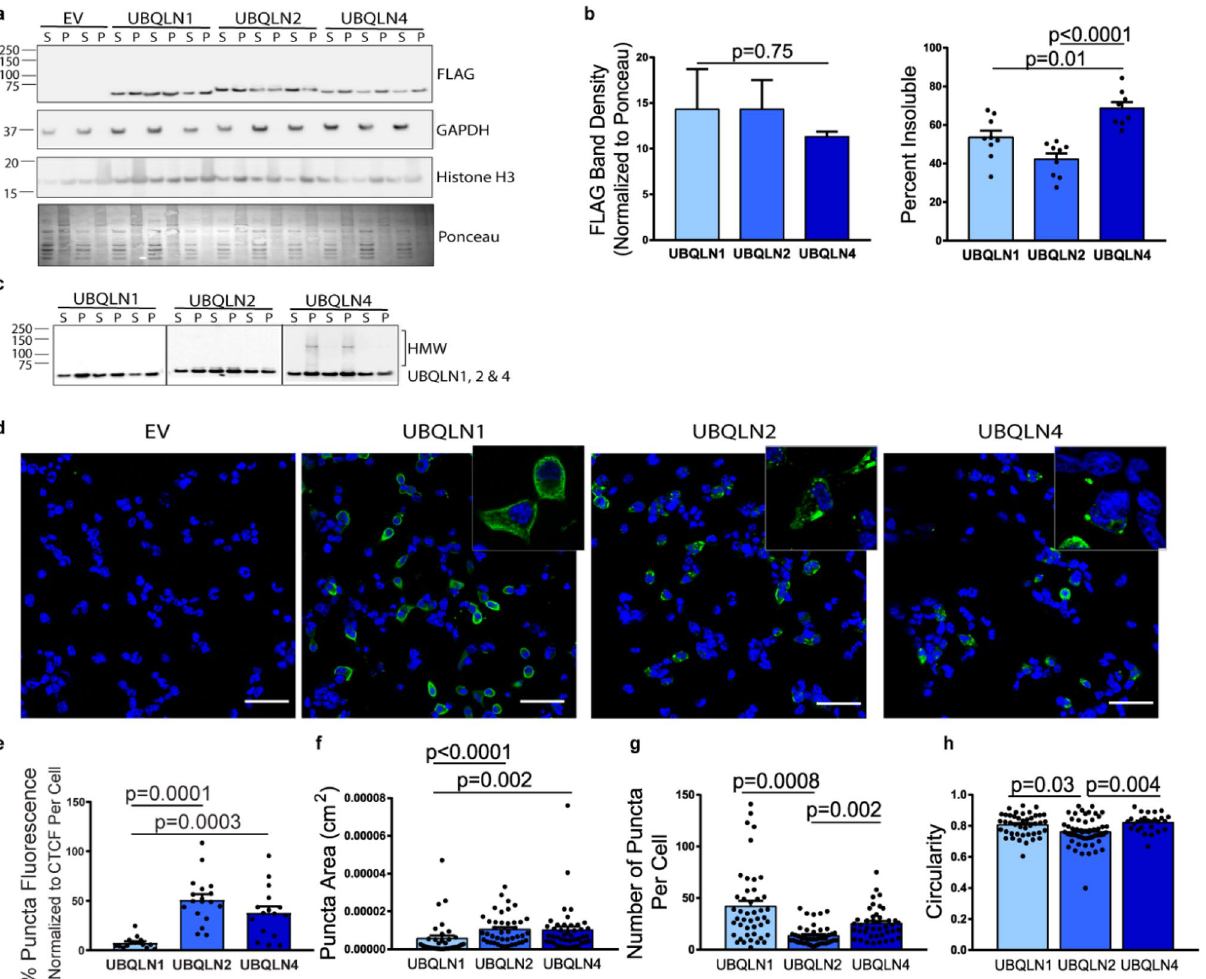
Figure 3. In transfected cells, UBQLN4 and UBQLN2 display enhanced aggregation and puncta formation compared to UBQLN1. ( a ) Of the three tested ubiquilins expressed in HEK-293 cells, FLAG-UBQLN4 is most prone to deposit in the PBS-insoluble (P) fraction versus the PBS-soluble (S) fraction (n = 9). Both cytoplasmic (GAPDH) and nuclear protein (Histone H3) is isolated in the soluble fraction. ( b ) All three ubiquilins were expressed equally as measured by total FLAG band density (normalized to Ponceau). For measurements of insolubility, values are expressed as percentage of protein that is PBS-insoluble, determined from the calculated total pool of PBS-soluble and PBS-insoluble. Data were analyzed by ANOVA. ( c ) UBQLN1, 2 and 4-specific antibodies (cropped to present all three antibodies in parallel) show that UBQLN4 partially electrophoreses as detergent-resistant high molecular weight species whereas UBQLNs 1 and 2 do not (uncropped Western blots are shown in Supplemental Figure S1). ( d , e ) Immunofluorescence of FLAG-UBQLNs 1, 2 and 4 shows that FLAG-UBQLN1 in HEK-293 cells is primarily diffusely expressed in the cytoplasm, whereas a higher percentage of FLAG-UBQLN2 and 4 is sequestered into large, heterogeneous puncta when normalized to corrected total cell fluorescence (CTCF) (n = 20). Characterization of puncta (n = 35–45/group) revealed that UBQLN1 puncta tend to be significantly smaller ( f ) and more numerous per cell ( g ) than UBQLN2 or UBQLN4 puncta , and UBQLN2 puncta are significantly less circular than either UBQLN1 or UBQLN4 puncta ( h ). Data were analyzed by Kruskal–Wallis test. Means and SEMs are displayed. Scale bar = 50